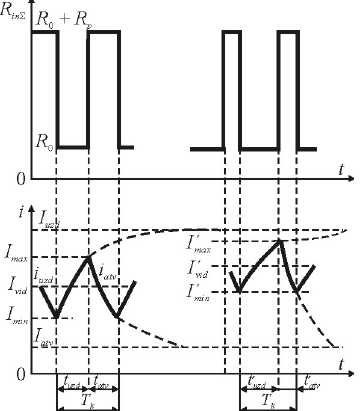
Fig 8. Diagrams showing the changes in rheostatic braking circuit parameter (resistor) during pulse regulation (a) and braking current